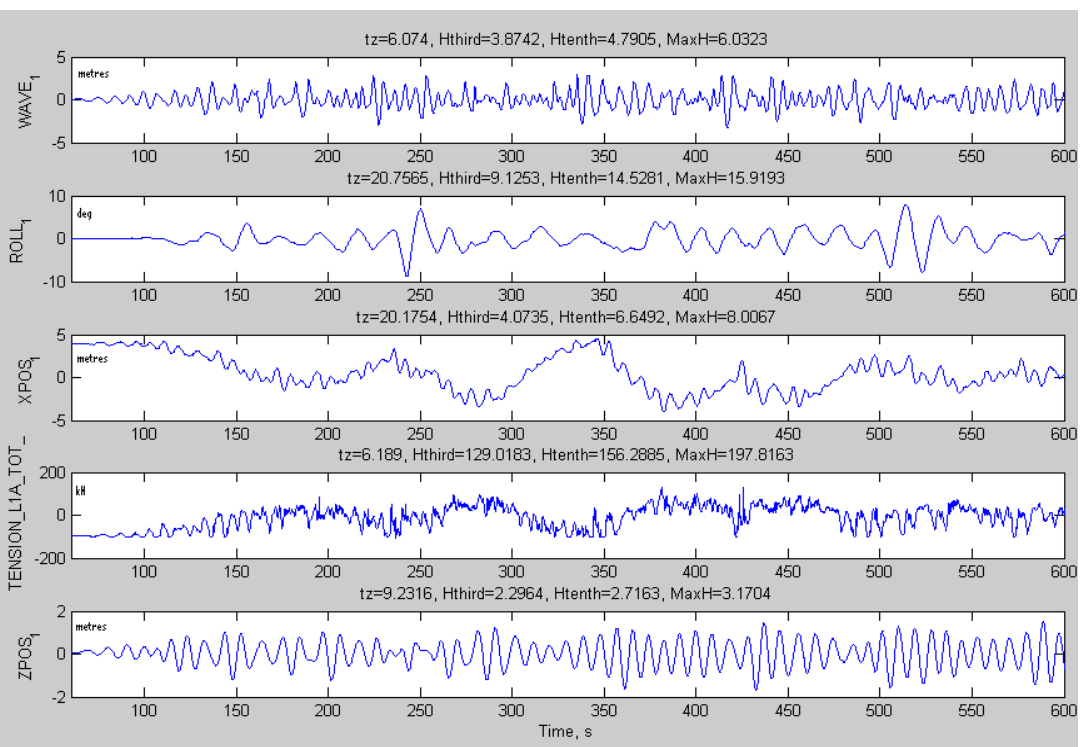
Figure 5. Example results for WEC1 in short-crested seas (test